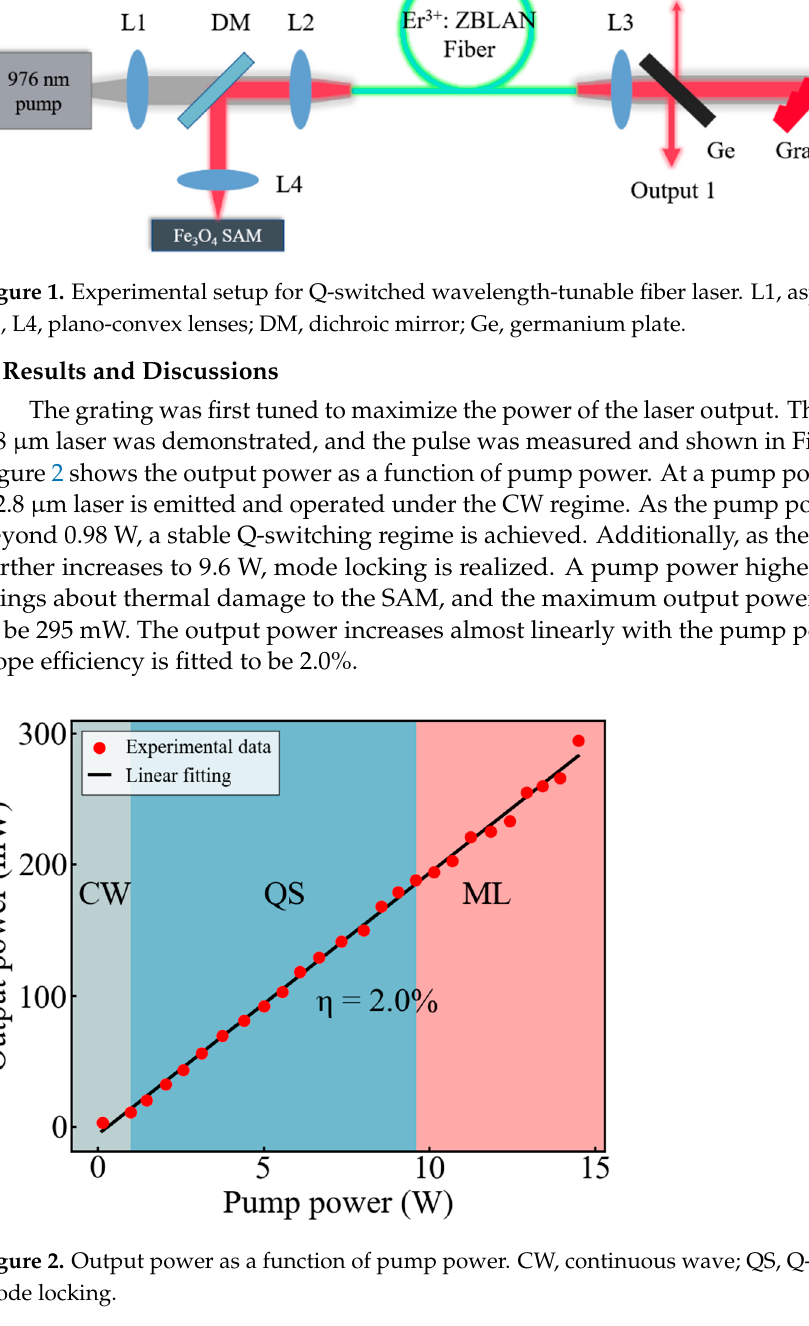
Figure 1. Experimental setup for Q-switched wavelength-tunable fiber laser. L1, aspheric lens; L2, L3, L4, plano-convex lenses; DM, dichroic mirror; Ge, germanium plate.